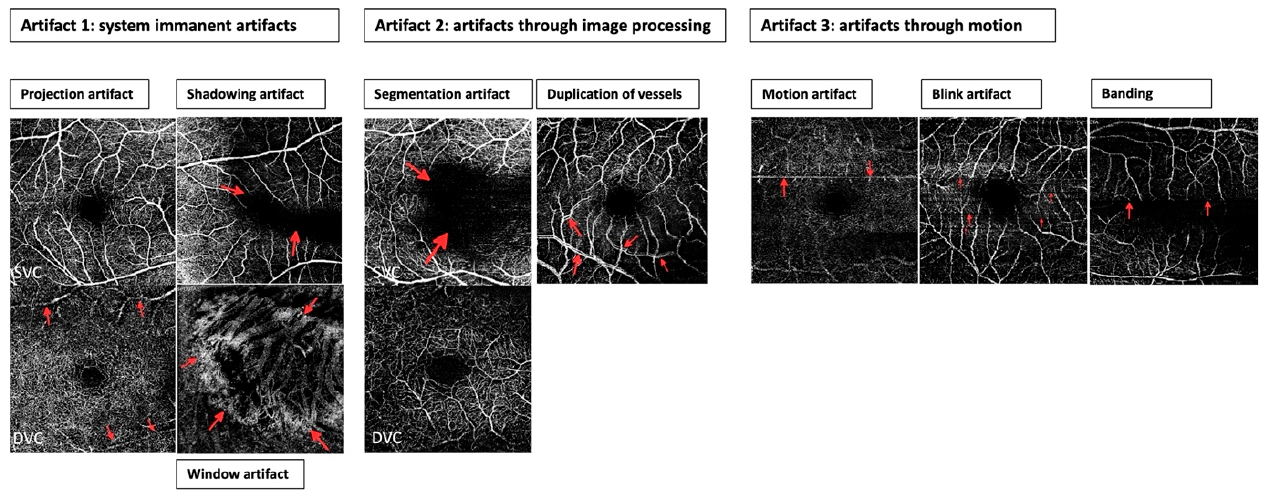
Figure 2. Artifact types. Three groups of artifacts can be distinguished. Artifact 1: system immanent artifacts that are irrespective of the type of device. This includes (1) projection artifacts (mostly in the deep vascular complex (DVC)): in DVC vasculature structures of superficial layers are imaged (red arrows); (2) shadowing artifacts: signal loss that image a black bar (red arrows); (3) window artifacts: visualization to choroid through retinal pigment epithelium loss (red arrows); Artifact 2: Artifacts through image processing. This includes (1) segmentation artifacts (mostly in the superficial vascular complex (SVC): errors in the automatic segmentation can conduct to unanalyzable, black areas (red arrows); (2) duplication of vessels: vessels are displayed in duplicate (red arrows). Artifacts 3: artifacts through motions. This includes (1) motion artifacts: very thin horizontal lines (red arrows); (2) blink artifacts: vertical and horizontal black lines (red arrows); (3) banding: adjacent horizontal stripes of different brightness (red arrows).